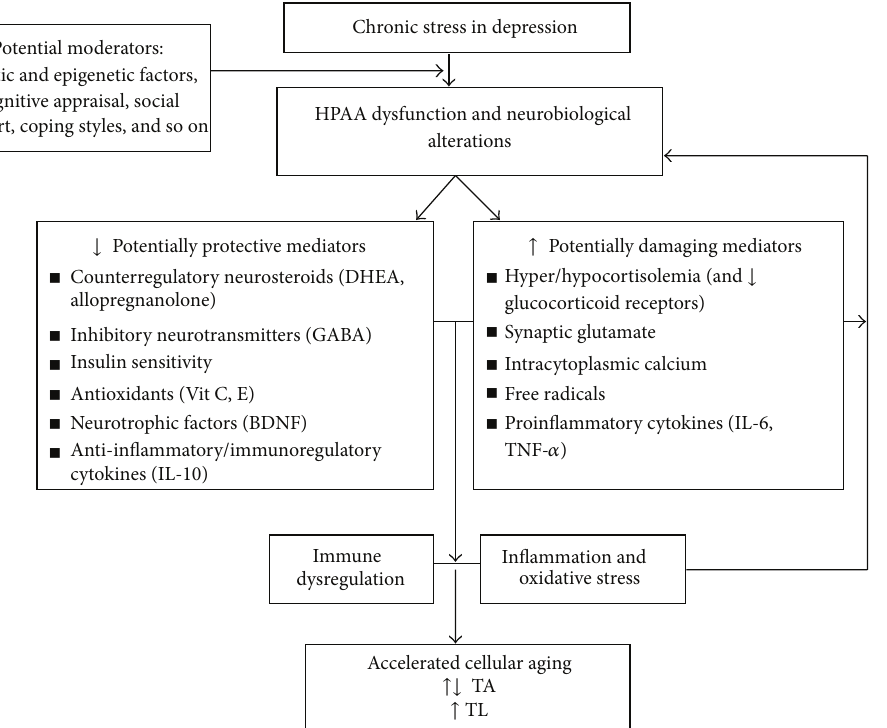
Figure 3: Highly simplified schema of mediators and moderators potentially related to cell damage or dysfunction, accelerated cellular aging, and